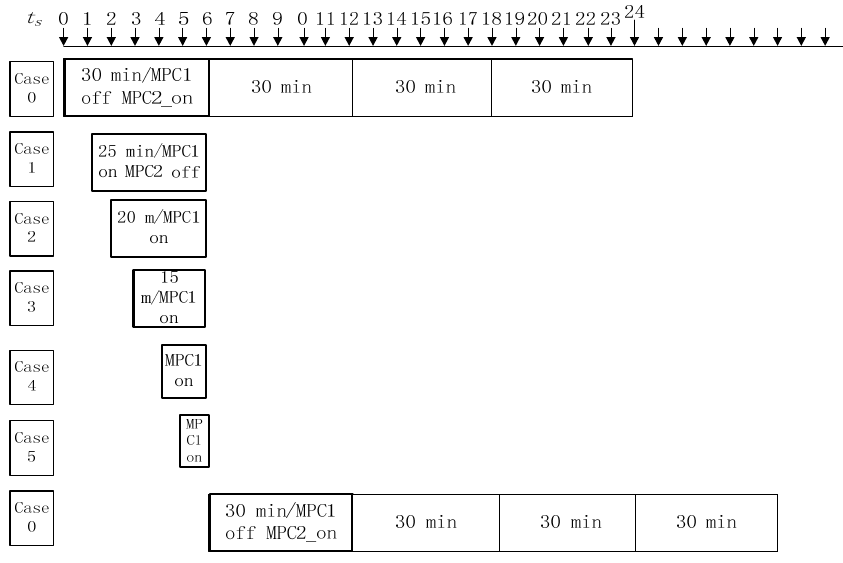
Figure 7. Two-level MPC performing rolling